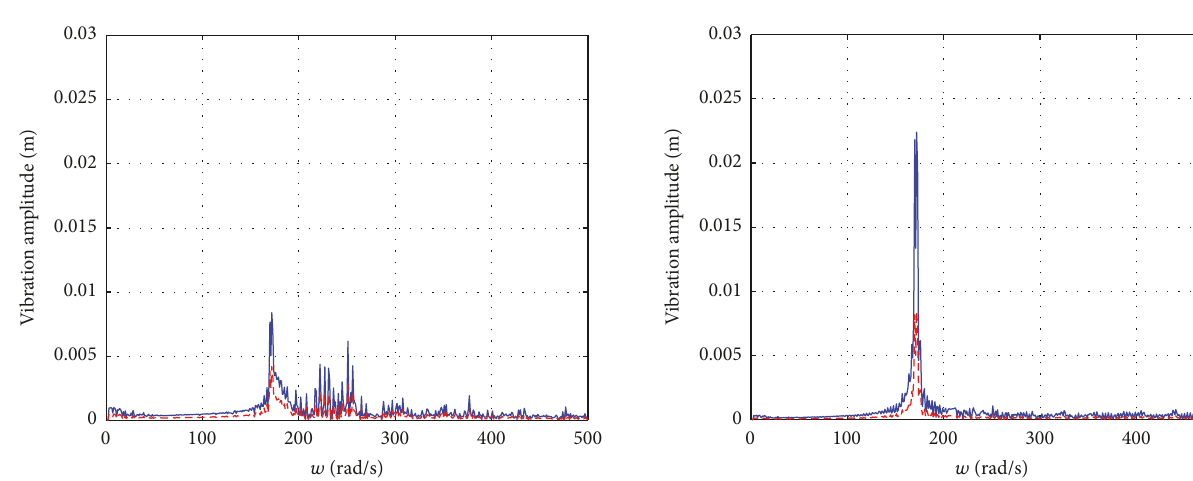
Figure 11: Comparison of two control effects (node 2).